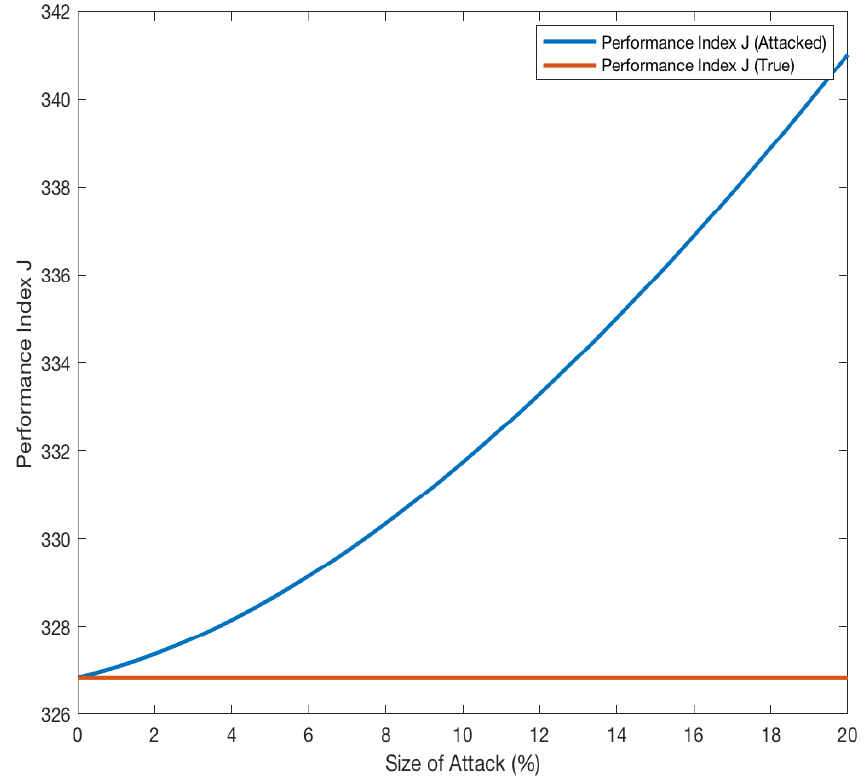
Figure 3. Performance Index (J) single line